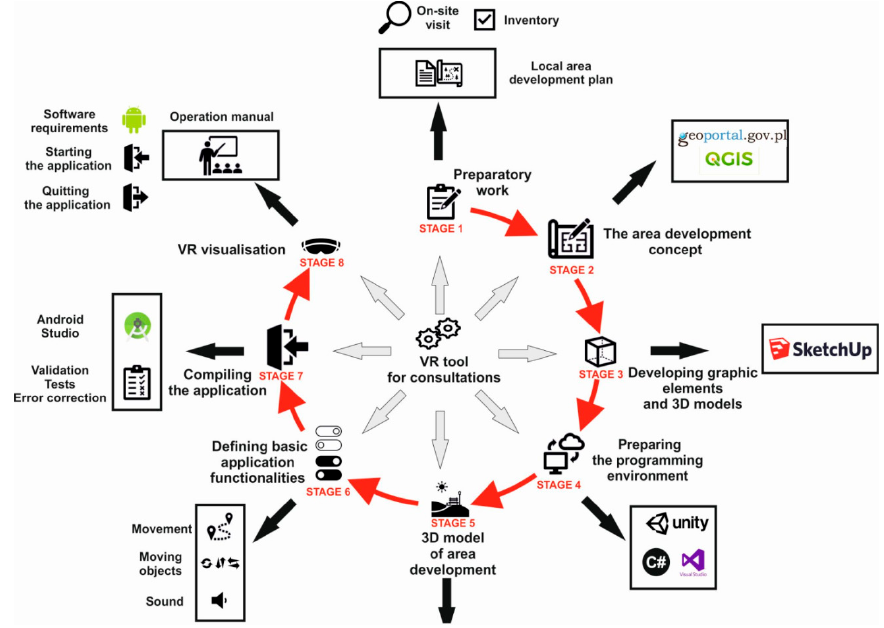
Figure 8. Stages of the execution of the project. Source: Prepared by the author. Table 2 shows brief characteristics of the main tools used in the project, complement ‐ ing and expanding the diagram of the project execution stages. Table 2. Tools used in the project and their characteristics.